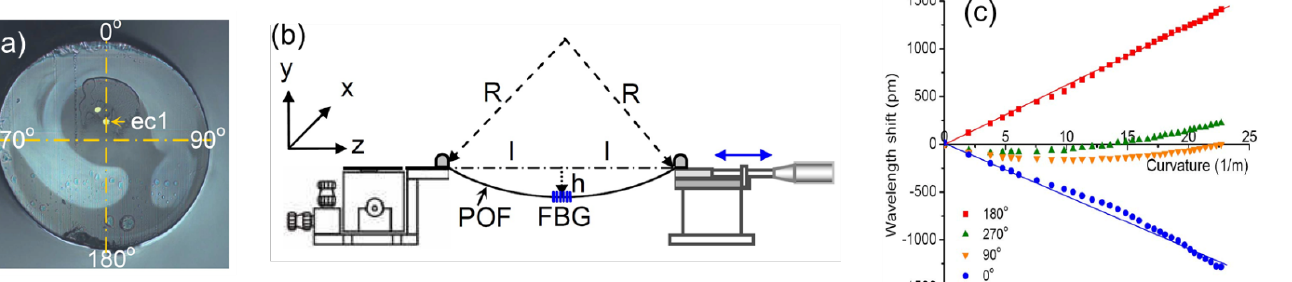
Figure 11. ( a ) Microscope image of the polymer fiber cross-section marked with the orientations; ( b ) schematic of the experimental setup for characterizing the FBG-based sensor. R is the bend radius and h is the displacement; ( c ) wavelength shifts of the eccentric polymeric FBG against curvatures at four different orientations. The symbols show the experimental data and lines depict the best-fit lines. Adapted with permission from Ref. [43] © 2010 IEEE.